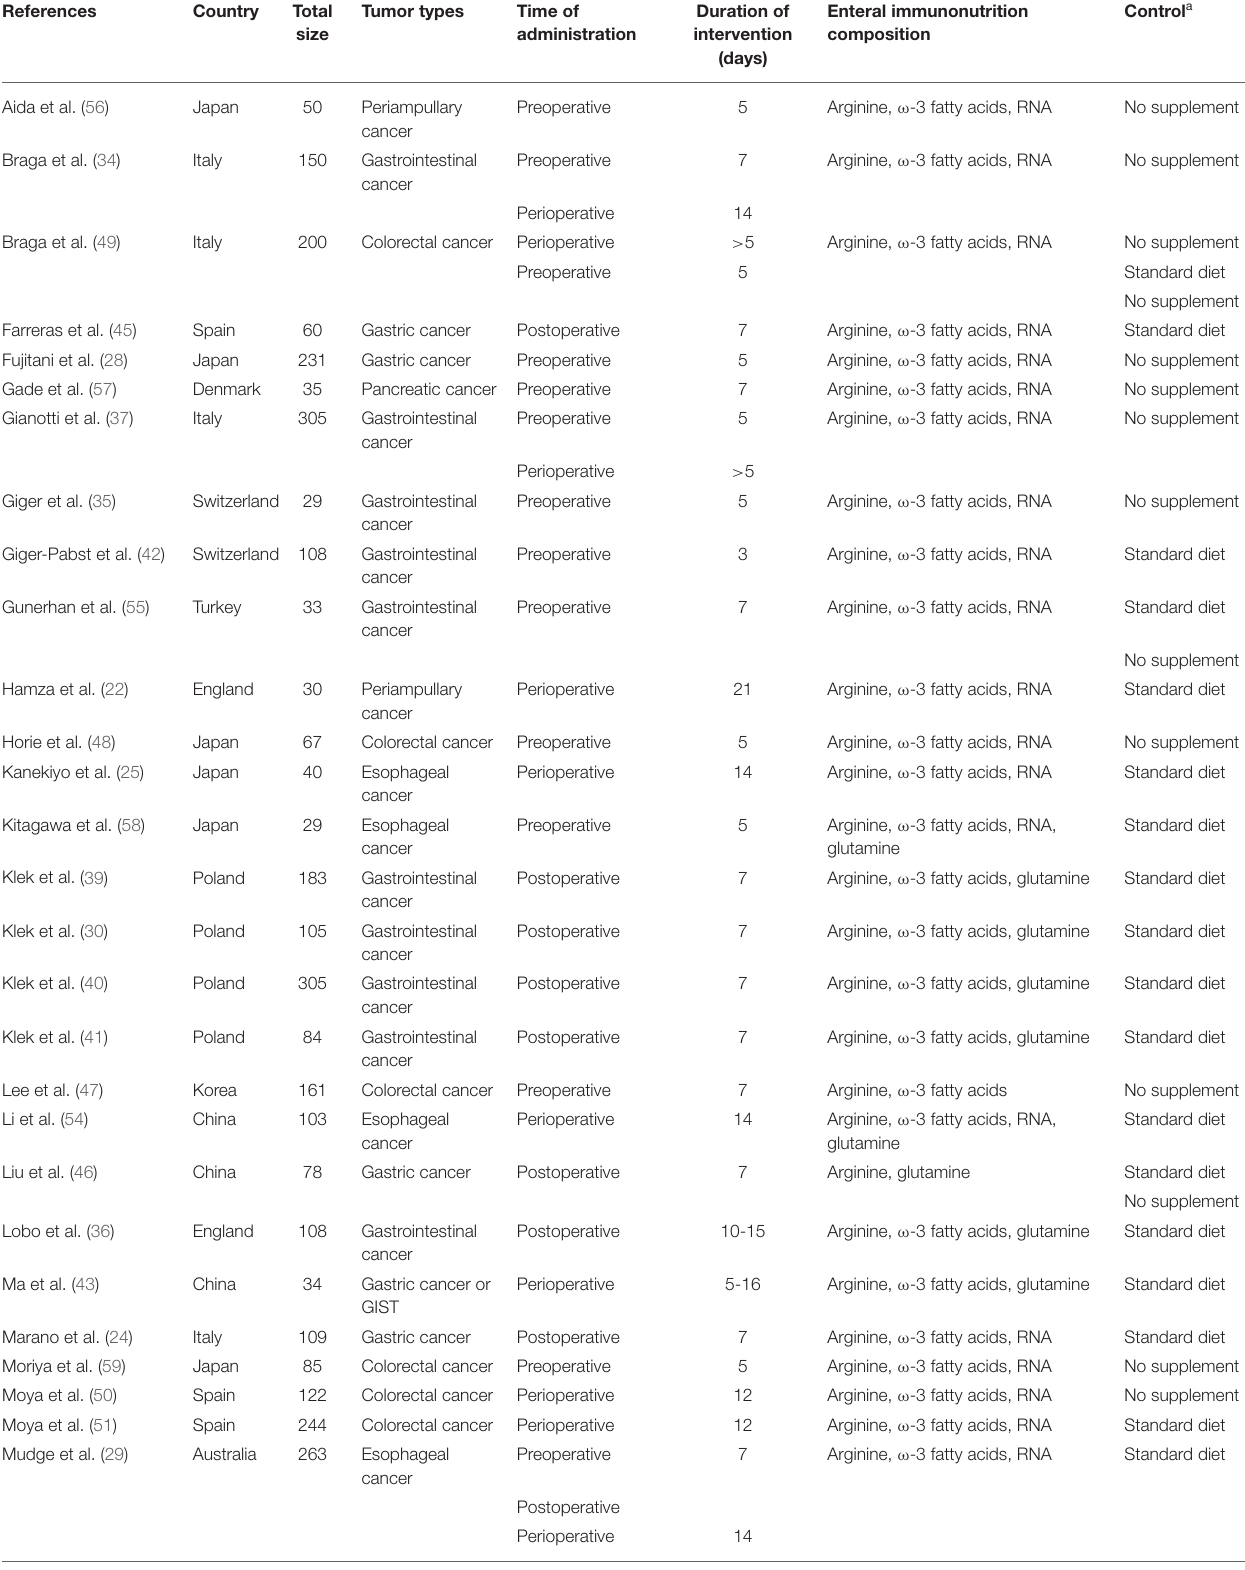
TABLE 1 | Characteristics of included clinical trials in the